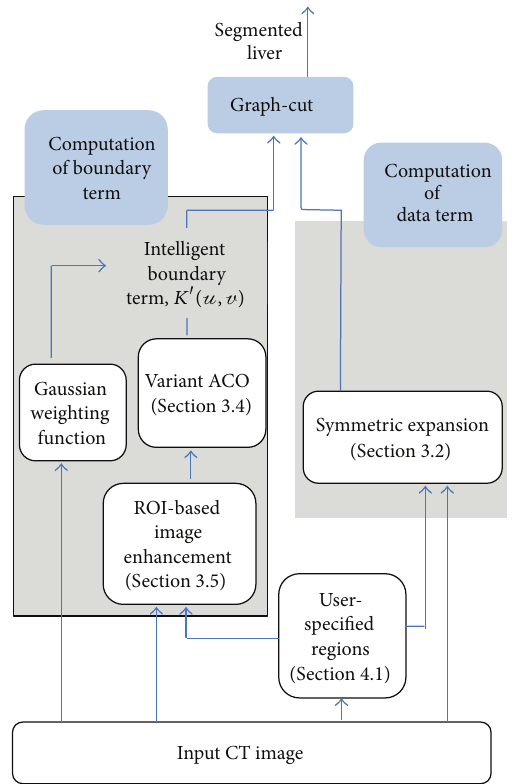
Figure 1: Overview of domain knowledge and swarm intelligence (DKSI) integrated